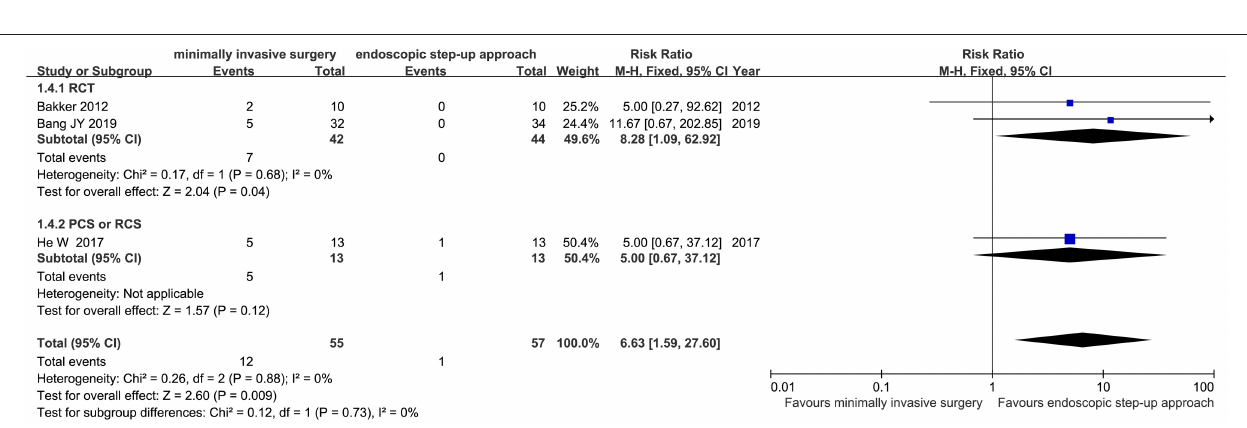
minimally invasive surgery group (MD = 11.26, 95% CI: 5.46– 17.05, P = 0.0001; Figure 9